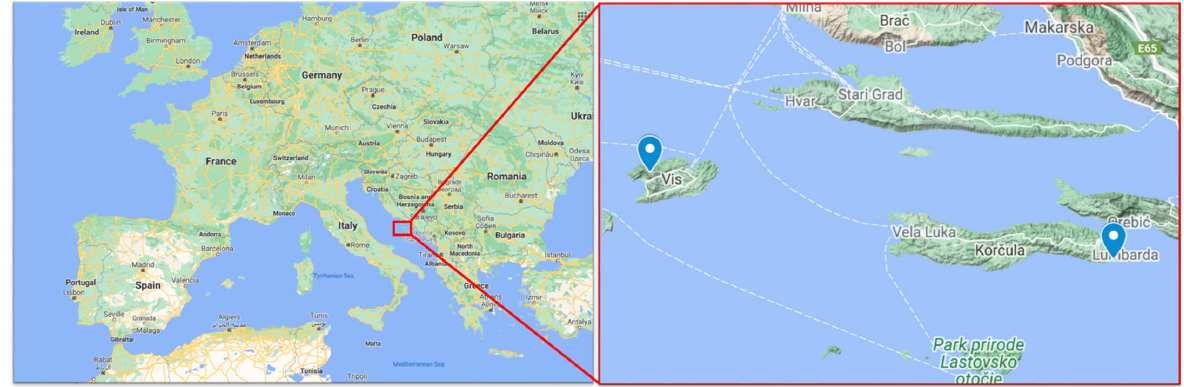
Figure 1. Location of the two vineyards on Dalmatian islands Kor č ula and